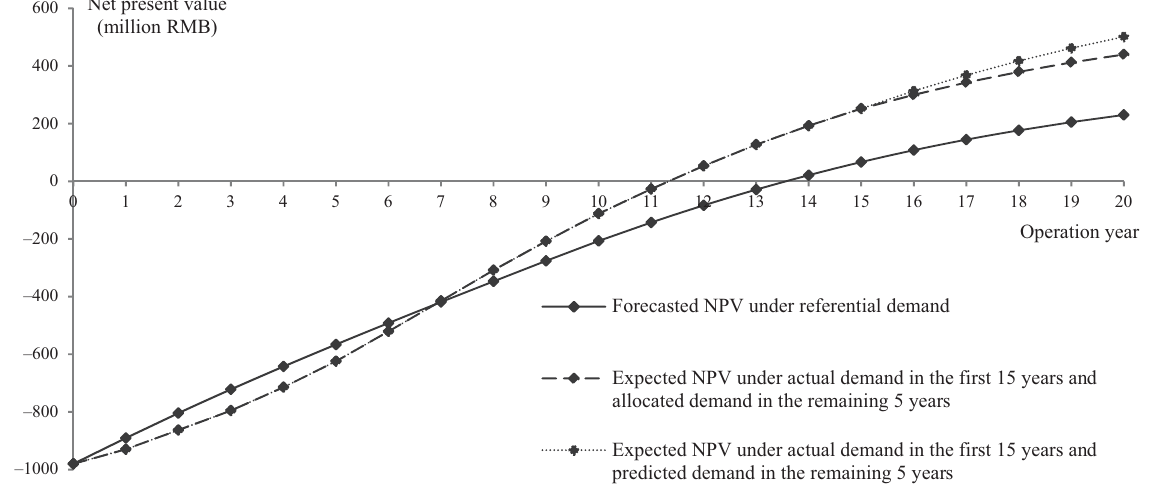
Figure 6. Net present value in three